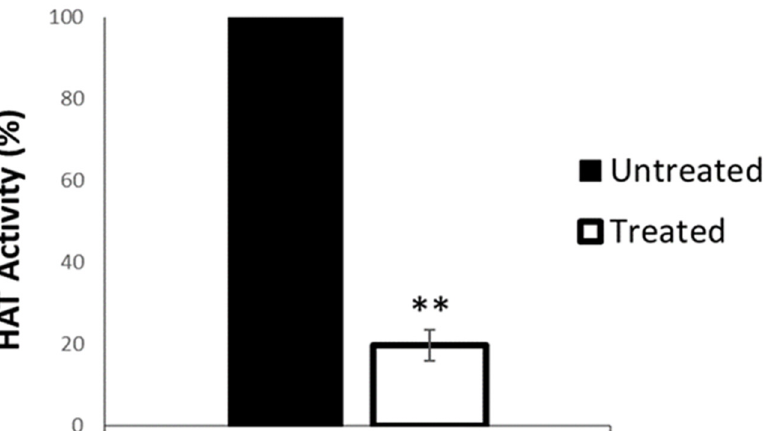
Figure 8. Compound 2c inhibits acetylase activity of HAC1. HAT activity of partially purified HAC1 catalytic site. Purified protein extracts treated with 6 µ M compound 2c compared to untreated samples. Similar results were obtained from two independent biological replicates, and one representative experiment is presented. The value of HAT activity is the mean of two technical replicates presented with SD values. Significant differences from the untreated samples were analyzed by t -test (** p ≤ 0.005).